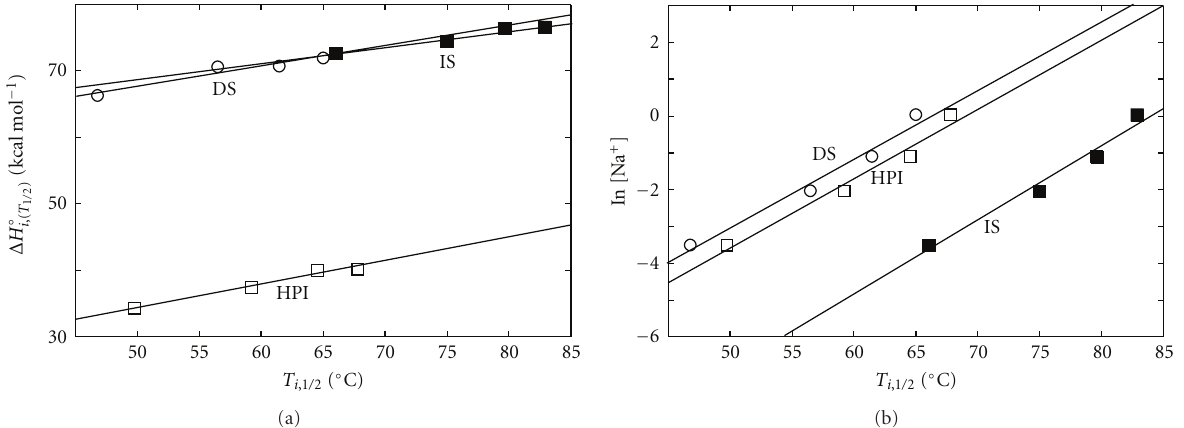
was determined for each transition i as the slope of , i and T i ,1 / 2 values determined at di ff erent salt concentrations; (b) ( T i ,1 / 2 )